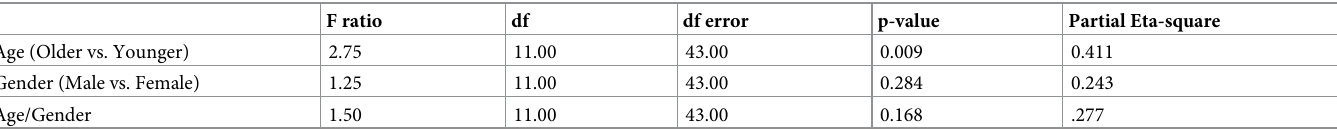
Table 3. Results of the MANOVA using Pilai’s trace for age, gender, and the interaction effect of age and gender on Presence , User Experience and Usability .